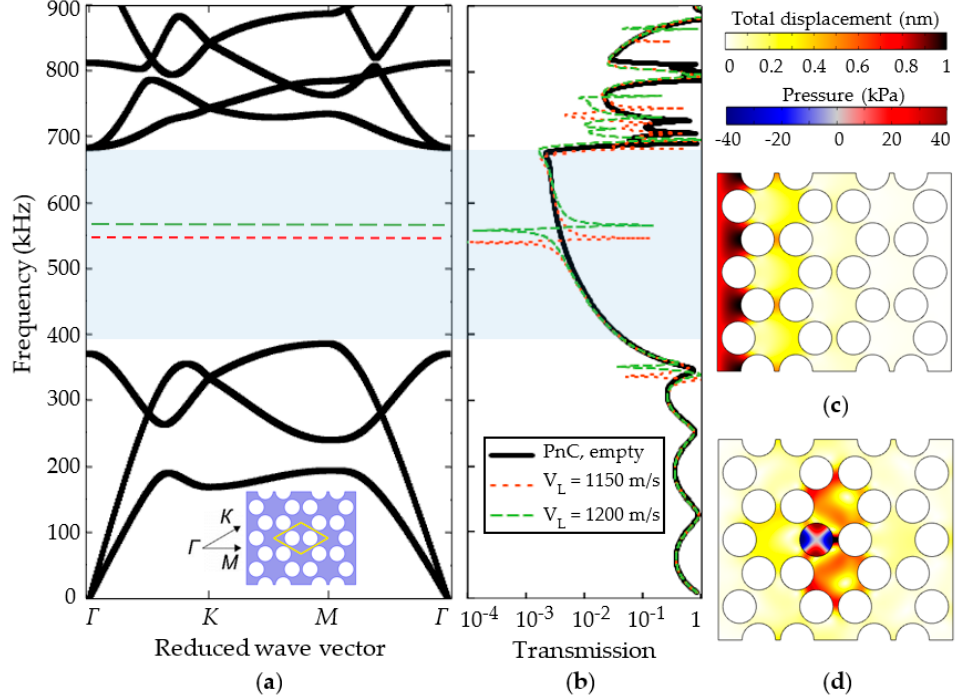
Figure 4. Theoretical results of the first type of phononic crystal sensor structure: ( a ) Band diagram for a 2D honeycomb infinite phononic crystal made of stainless steel with periodic hollow cylinders in a honeycomb arrangement (black solid curves) and localized substitution type defect state inside of the bandgap associated with liquid-filled hole for two di ff erent speed of sound values (green and red dotted curves); ( b ) transmission spectrum of the regular finite phononic crystal structure (black solid curve) and the structure with a liquid-filled defect for the two di ff erent speeds of sound; ( c ) total displacement distribution of the honeycomb-type phononic crystal structure exited at the boundary in the direction of wave propagation at the mid-bandgap frequency; ( d ) total displacement distribution of the phononic crystal structure with the liquid-filled local defect at the frequency of the second spinning pressure mode. The minimum of displacement for both demonstrated cases correspond to the white color.